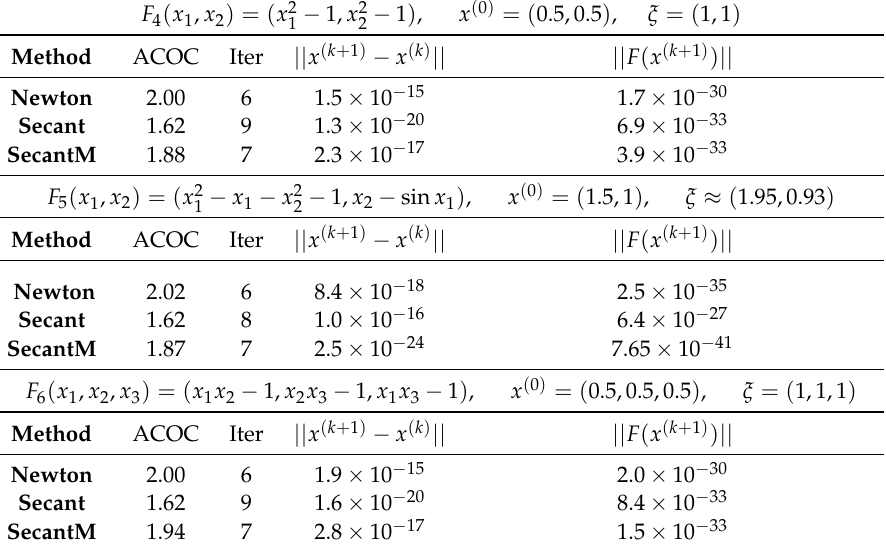
Figure 6. Dynamical planes for F 5 ( x 1 , x 2 ) = ( x 2 Table 2. Numerical results for the vectorial functions F 4 ( x ) , F 5 ( x ) , F 6 ( x )